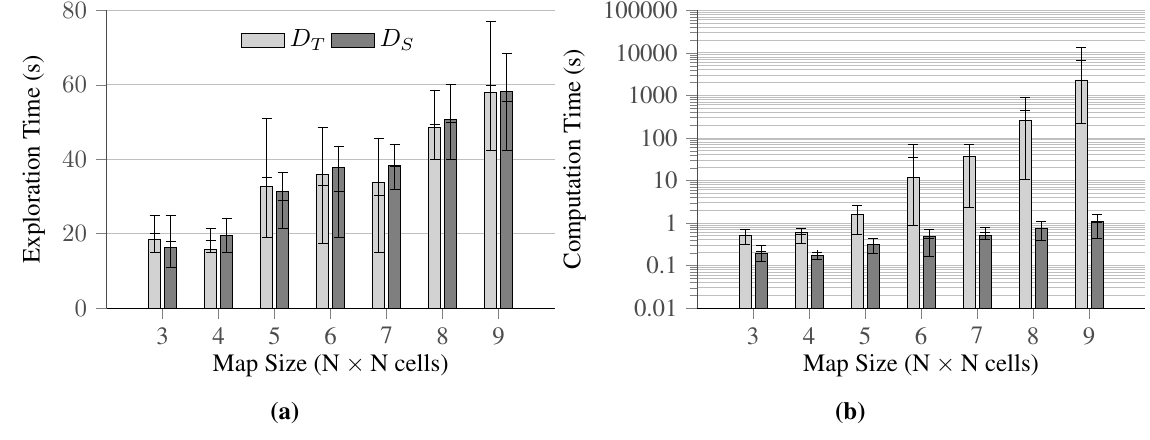
Figure 7. Comparison of two disjoint approaches up to maps of size 9 × 9. Notations are similar as in the previous figure, i.e. , bars indicate the average values over the 3 maps for 3 × 3 and 10 maps for the rest, and error bars indicate the minimum and maximum values observed during the trial. ( a ) shows the solution quality of two disjoint approaches ( D and ( b ) shows the average computation time on a logarithmic scale for both